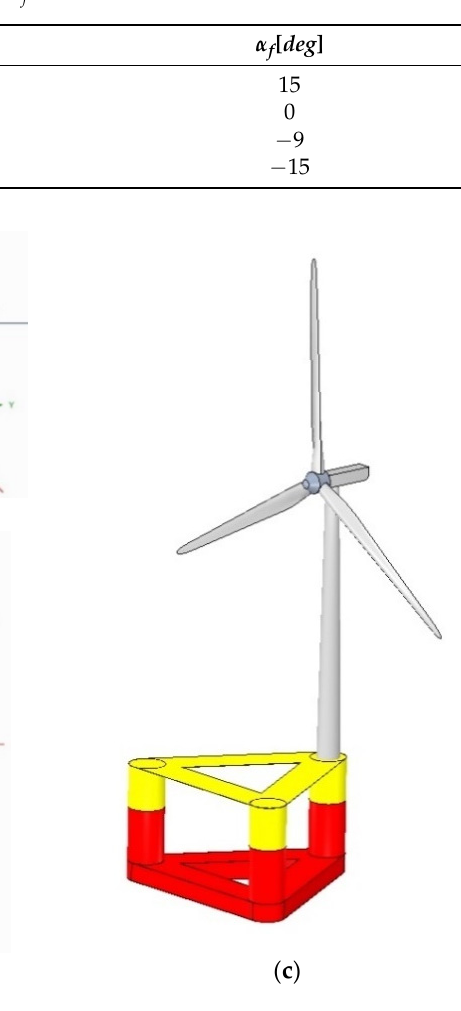
Figure 10. Sketch of three ‐ column platform floating wind turbine system: ( a ) front view of three ‐ column platform; ( b ) top view of three ‐ column platform; ( c ) isometric view of three ‐ column floating wind turbine system.